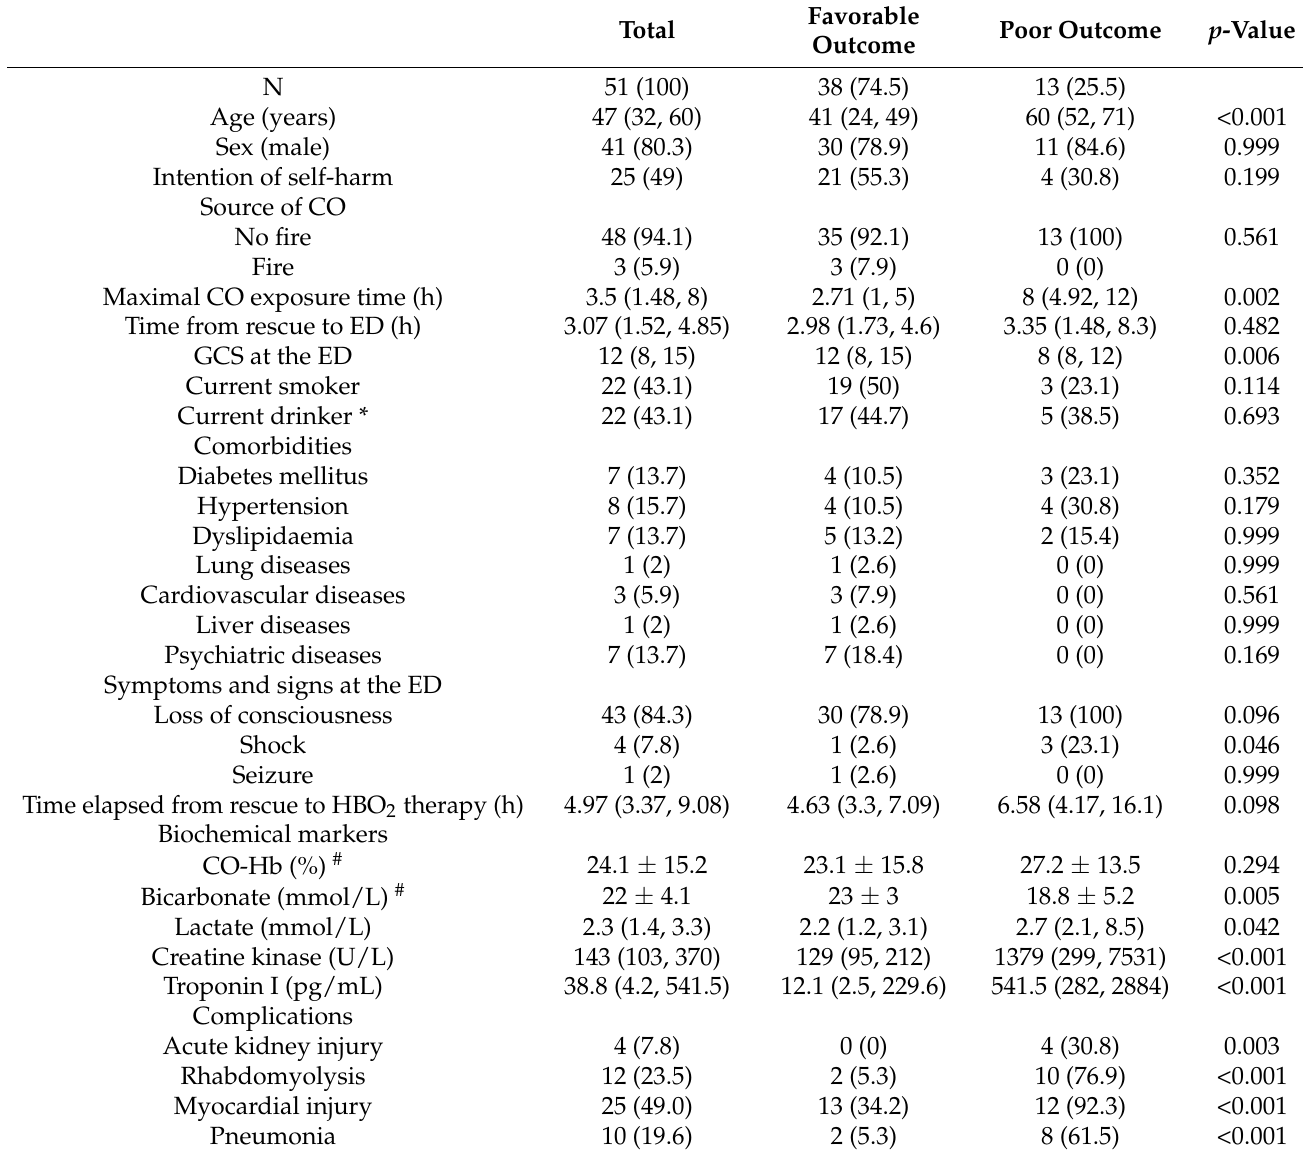
Table 1. Demographic and baseline characteristics of the patient